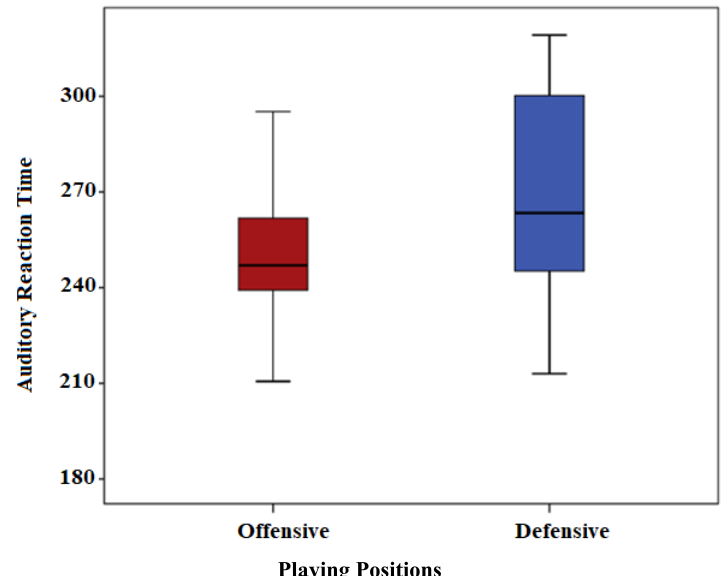
Figure 5. Comparison of Auditory Reaction Time (ms) of players according to playing